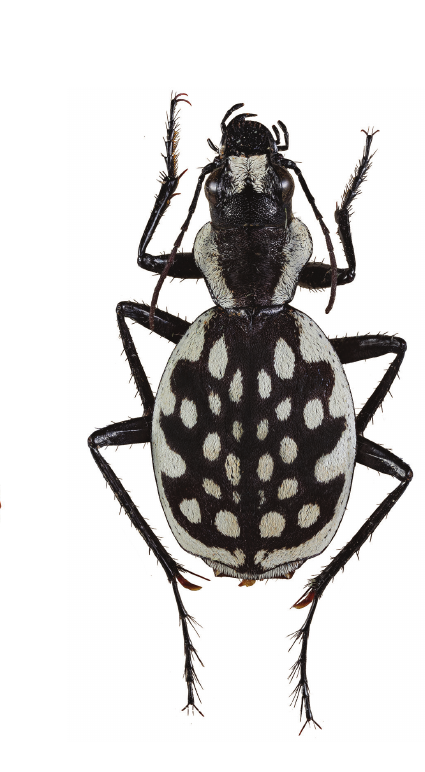
a b Figure 22. Dorsal habitus of Graphipterus : a G. magnus sp. n. b G. mauretensis sp. n. I triangular, extension I and II elongated. Elytra widest at interior rear third, drop-like shape. Median lobe of aedeagus with slightly bent